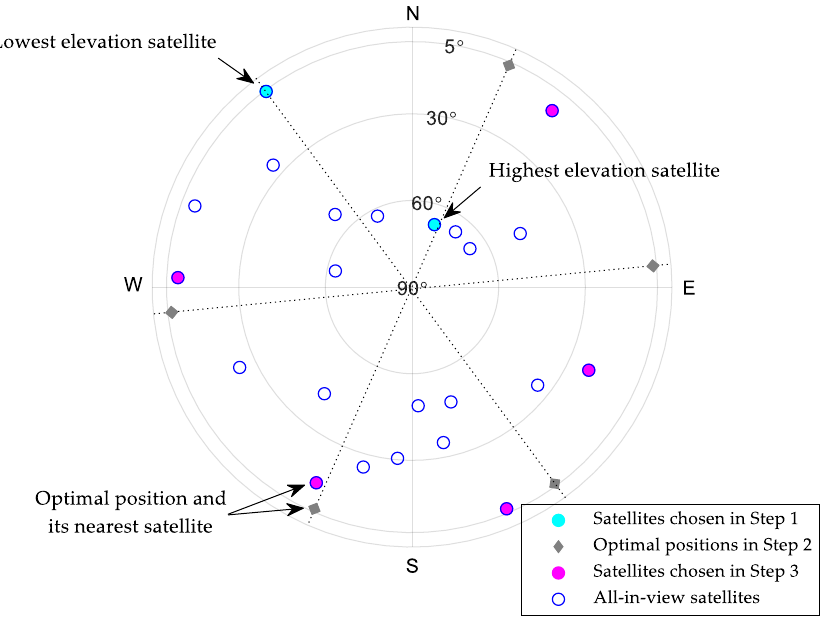
Figure 3. An example for initial subset selection when 𝑚 = 7 .